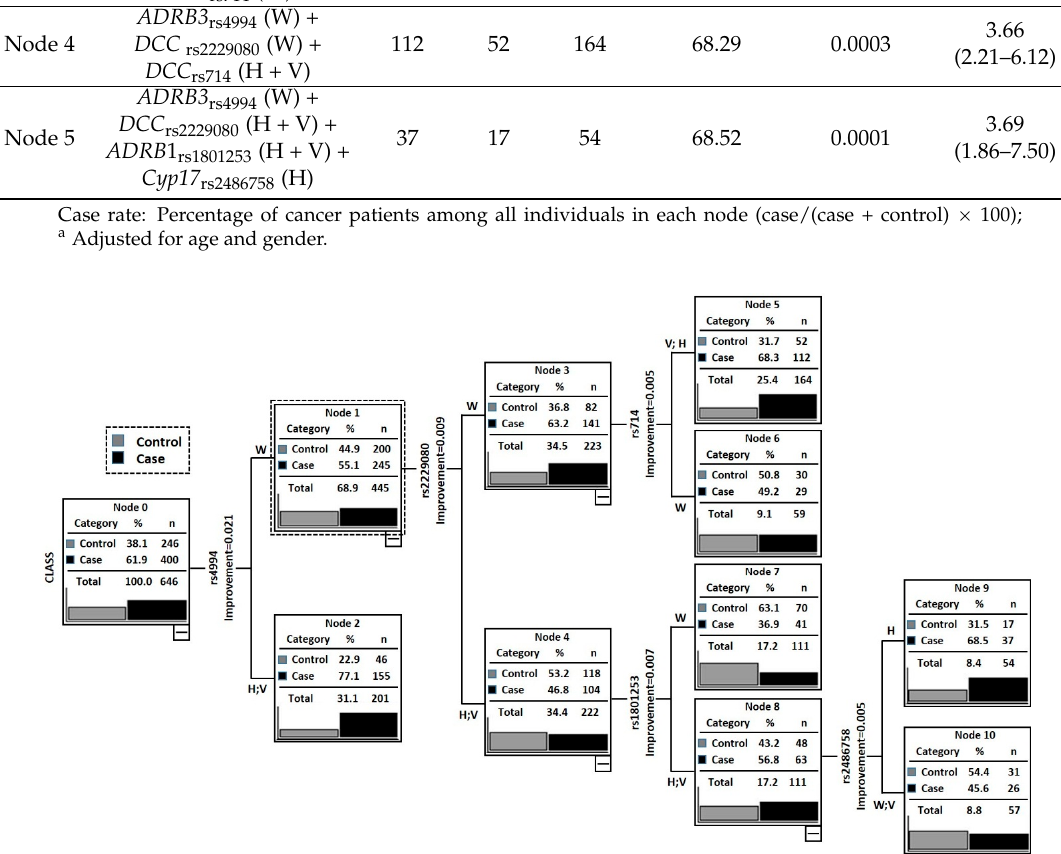
Figure 1. Classification and regression tree model for selected 14 SNPs and GBC risk. Terminal nodes at the end. W: Wild type genotype; V: Variant genotype; H: heterozygous.